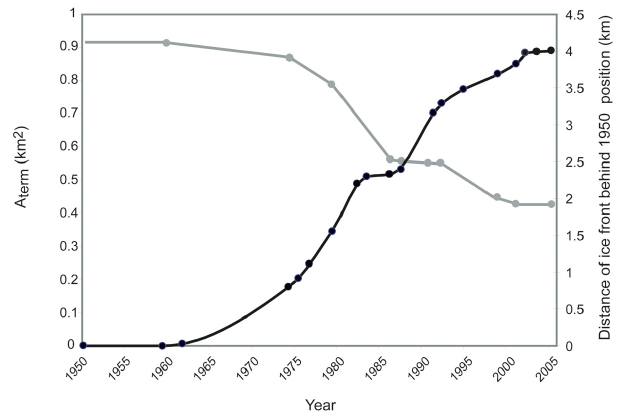
Fig. 4. History of the ice-front area A term (grey line) calculated from the bathymetry of Laguna San Rafael, known terminus posi- tions (black dots), and interpolated terminus positions (black line) (see Fig. 3). For the calculation of changes in A term over time we assume that, on average, the cliff height across the terminus was 40m above the water